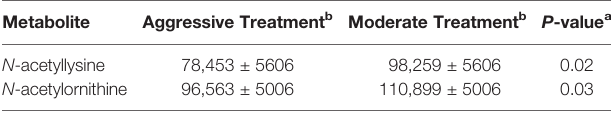
TABLE 3 | Metabolites differing between aggressive and moderate implant strategies. Metabolite